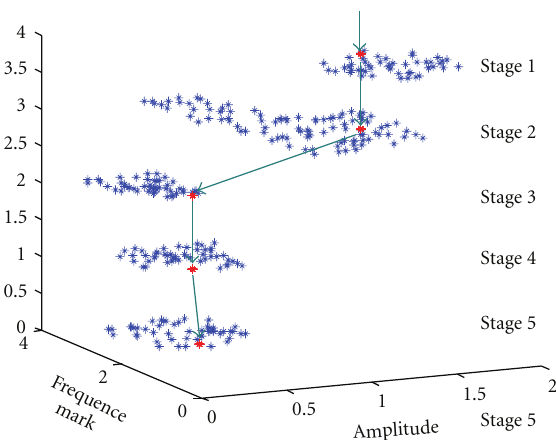
Figure 12: Presentation of Optimal search strategy without error event signals.